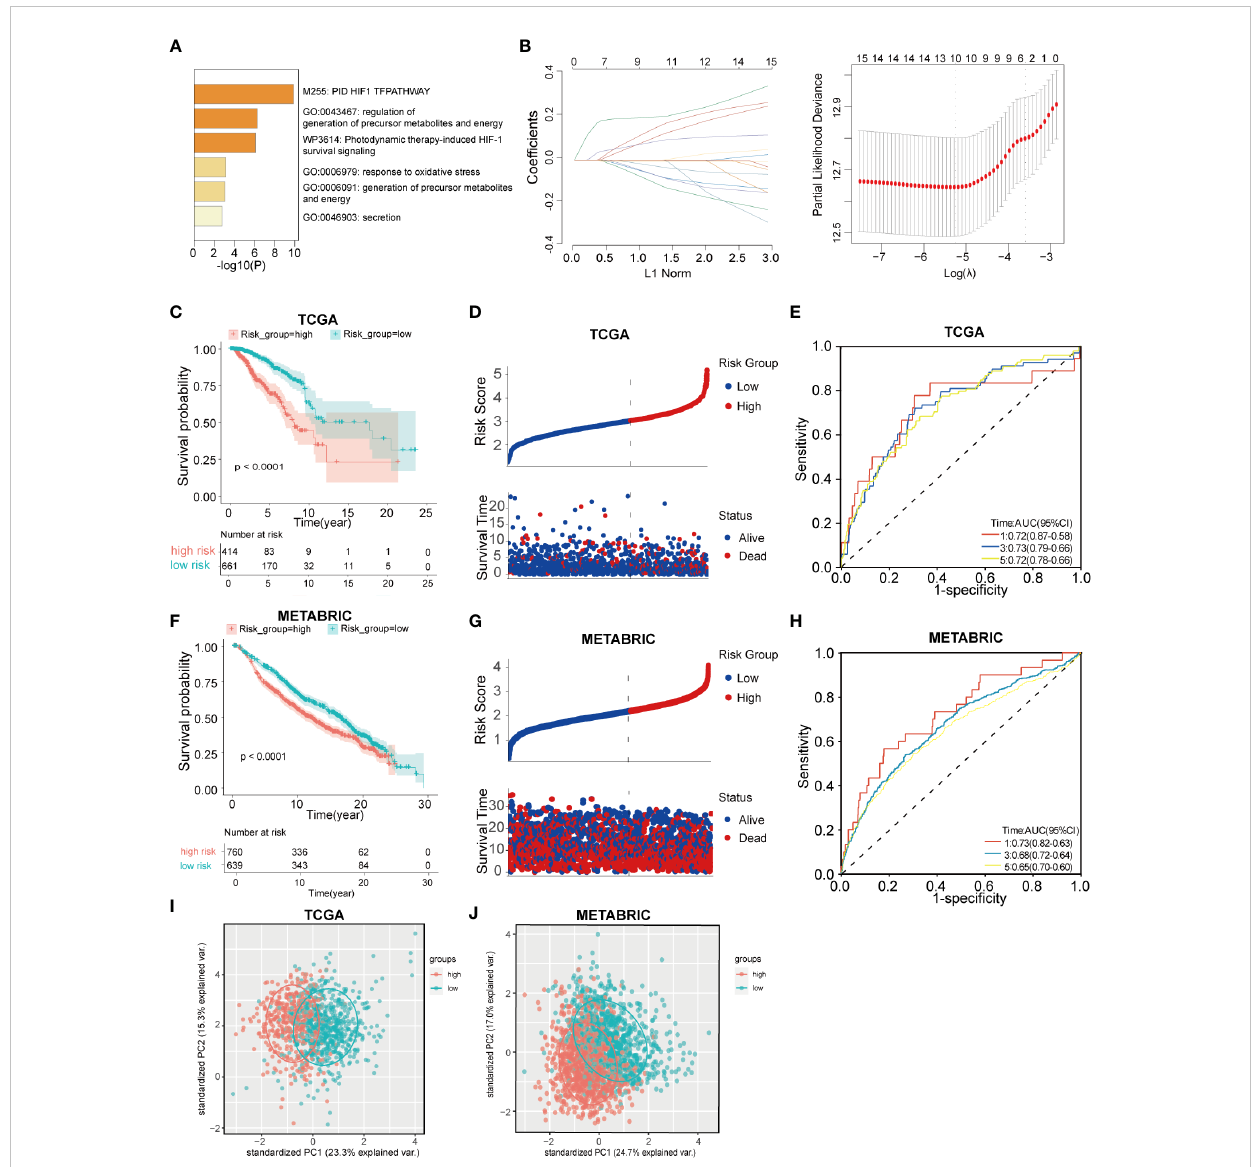
FIGURE 2 Construction and validation of hypoxia and ferroptosis-related gene risk signature(HFRS) in BC patients. (A) The barplot shows the enrichment of Go pathways signi fi cantly associated with prognostic HRGs and FRGs. (B) LASSO regression analysis identi fi ed 10 hub genes to construct HFRS signature. (C) Kaplan – Meier curves show the signi fi cant difference in overall survival between high- and low-HFRS groups in TCGA cohort. (D) The ranked dot plot indicates the HFRS_score distribution; scatter plot present the patients ’ survival status in TCGA cohort. (E) The ROC curves of HFRS for predicting 1, 3, and 5 years overall survival in TGCA cohort. (F) The K-M curves show the signi fi cant difference in overall survival between high- and low-HFRS groups in the METABRIC cohort. (G) The ranked dot plot indicates the HFRS_score distribution; scatter plot presents the patients ’ survival status in the METABRIC cohort (H) The ROC curves of HFRS for predicting 1, 3, and 5 years overall survival in METABRIC cohort. (I) The PCA plot based on HFRS gene expression show the distinct subgroups of TCGA BC cohort. (J) The PCA plot based on HFRS gene expression divided the METABRIC BC cohort to two